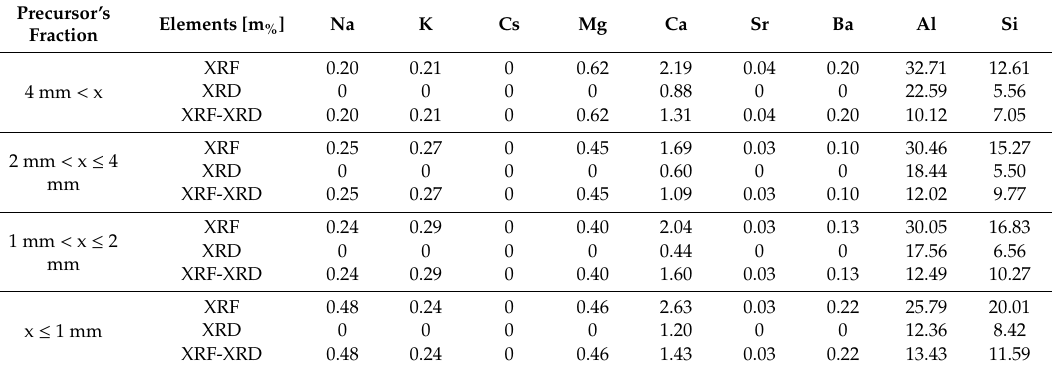
Table 1. 1st row of precursor’s fractions presents the mass percentage of elements measured with X-ray fluorescence (XRF), 2nd row mass percentage of elements in the crystalline phase that was determined with Rietveld refinement from XRD, 3rd row mass percentage of elements in the amorphous phase.